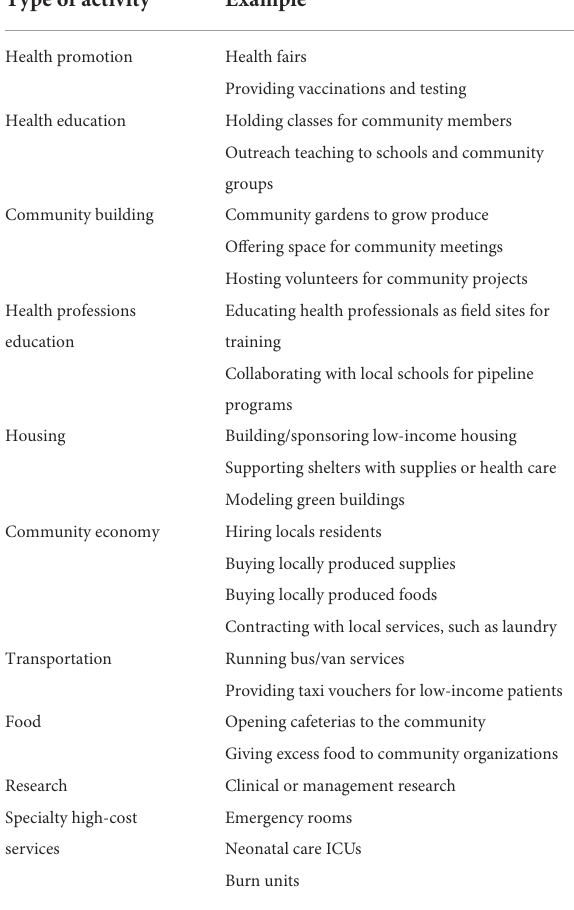
TABLE 1 Hospital community benefit